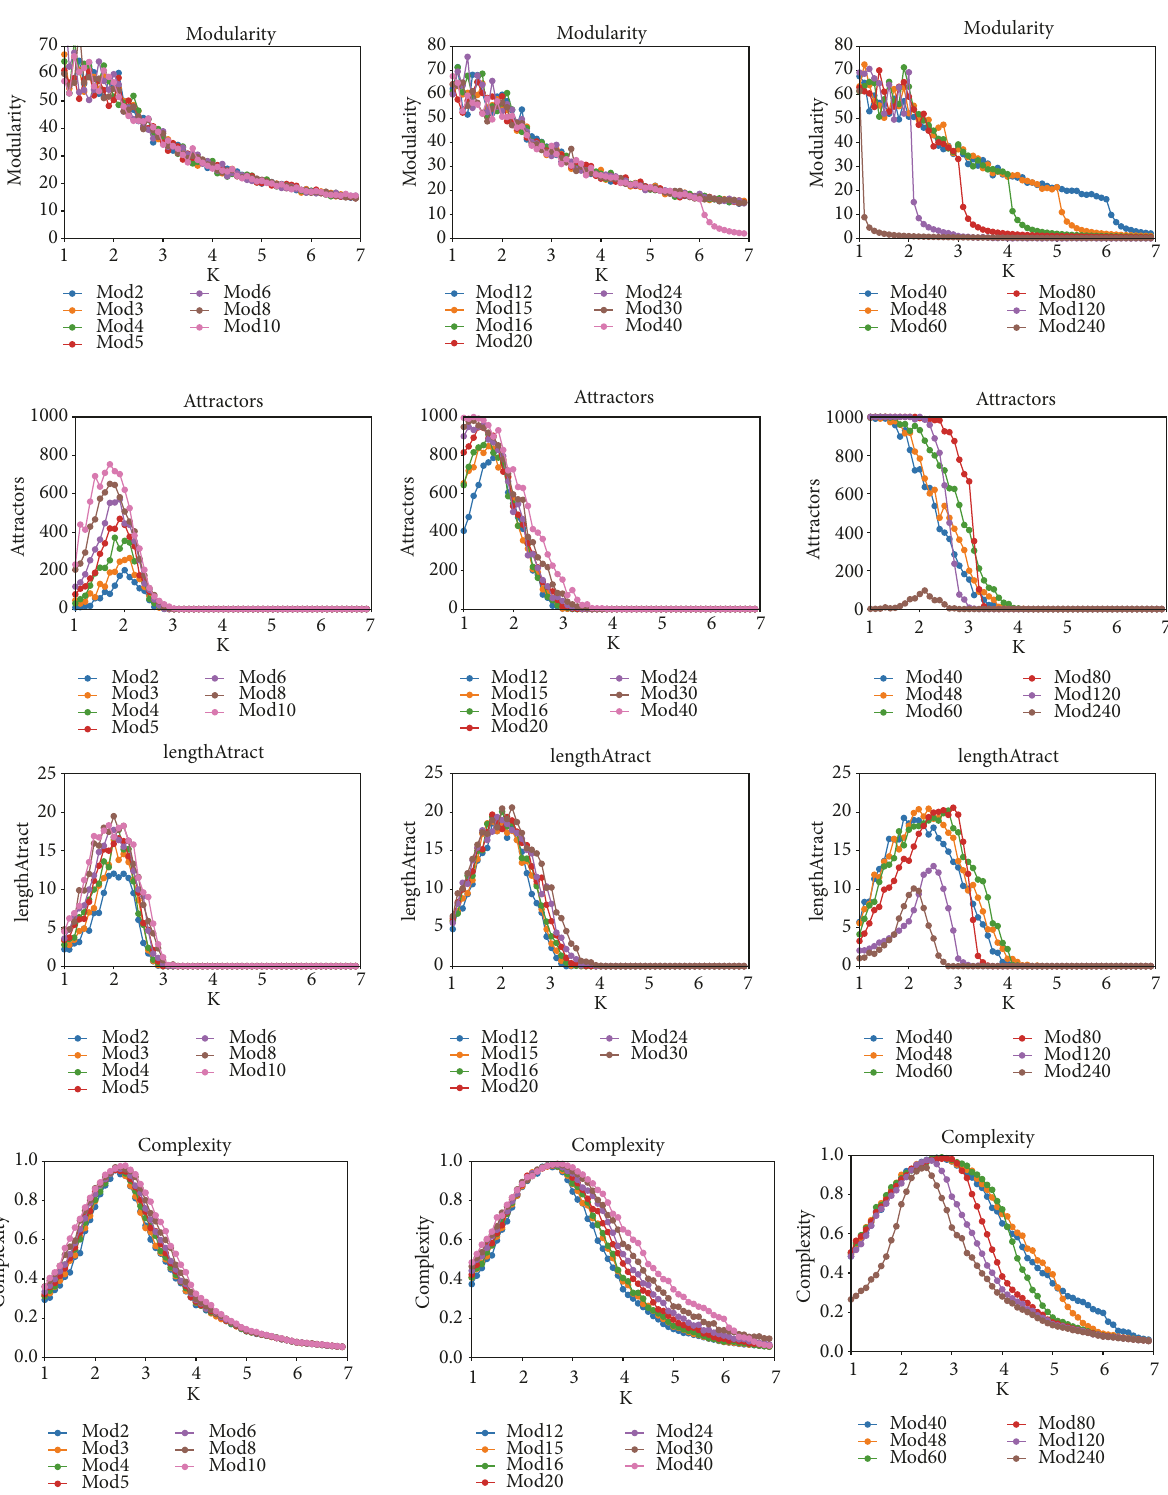
Figure 6: Modularity, numbers of attractors, average length of attractors, and complexity for modular